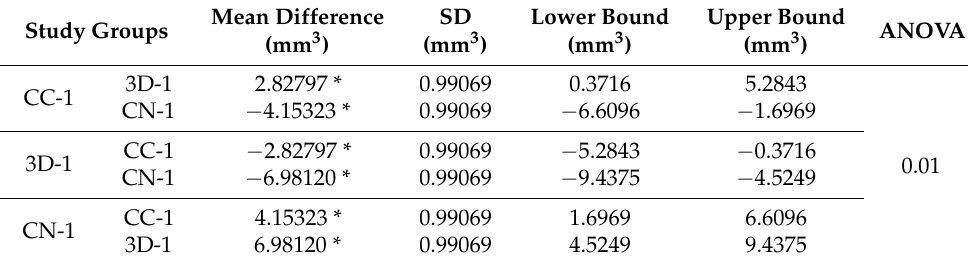
Table 6. Comparison of surface wear/loss (mm 3 ) between the study groups. Study Groups